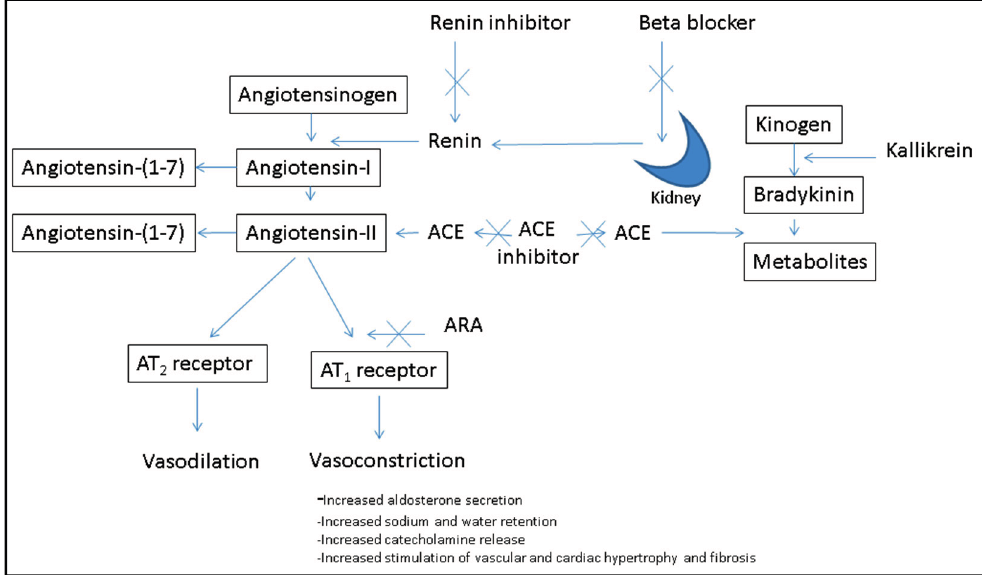
Figure 1. The Renin-Angiotensin-Aldosterone System (RAAS) can be inhibited by ACE-I inhibitors, angiotensin II type 1 receptor antagonists (ARA), renin inhibitors and beta blockers. ACE-I also plays a role in bradykinin metabolism and metabolism of